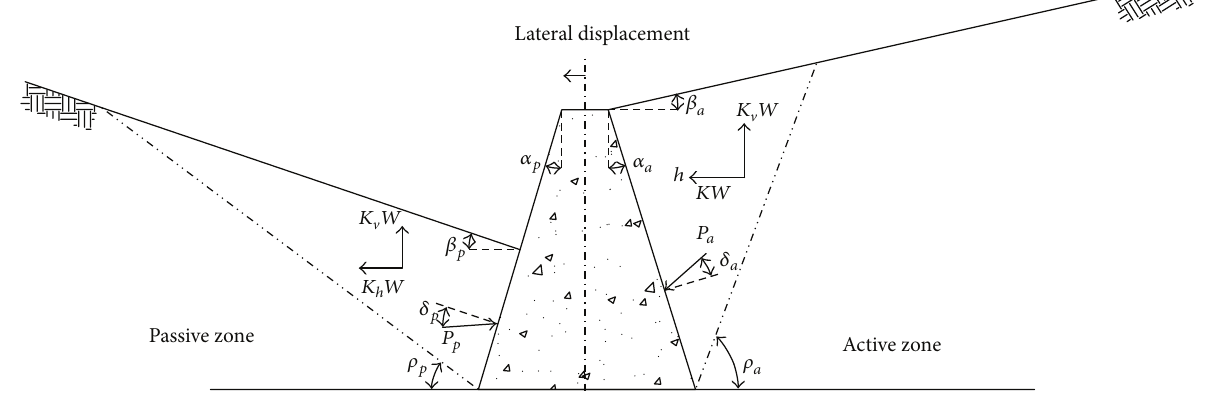
Figure 2: Geometry and parameters of M-O